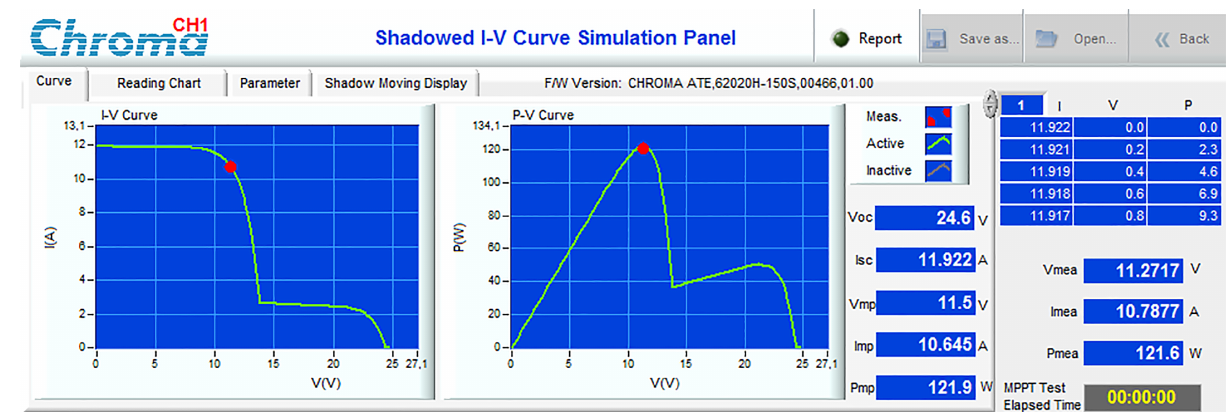
Figure 8. Simulated partial